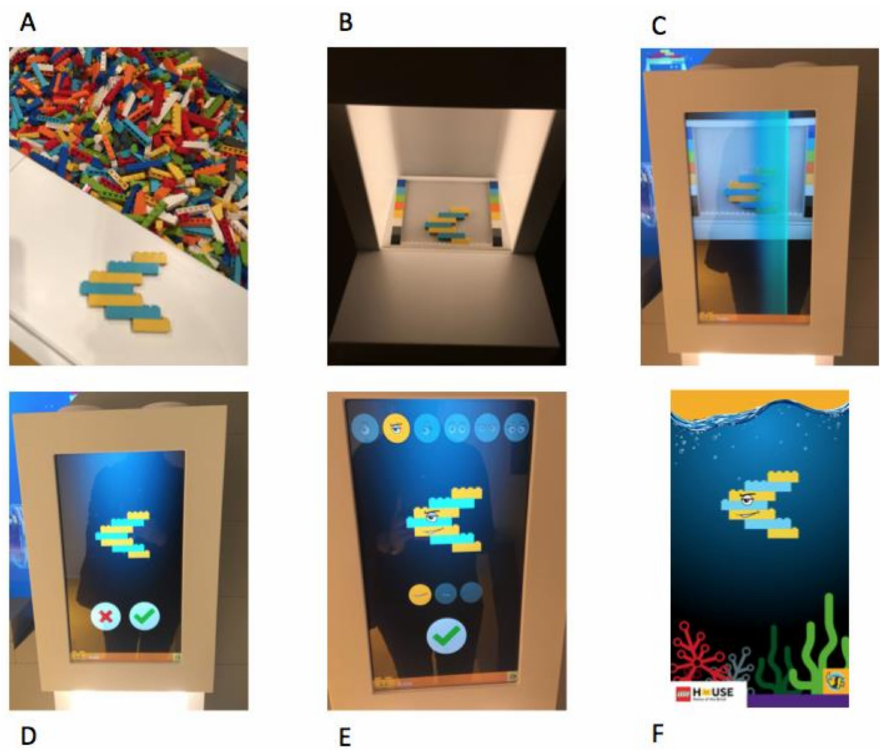
Figure 6. A – F : Stages of fish